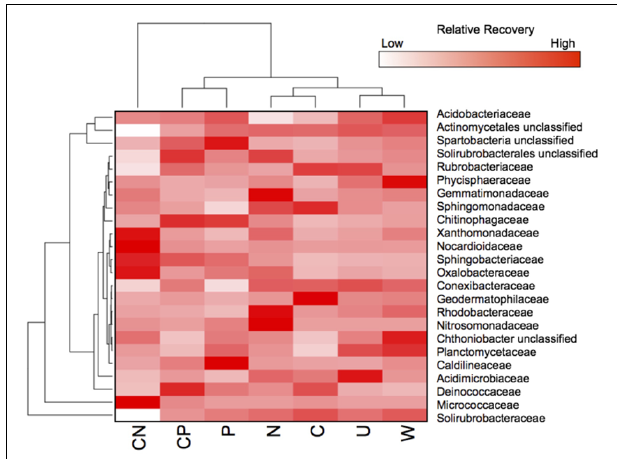
FIGURE 3 | All resources, except water, promoted different taxonomical shifts. Heat map showing the distribution of OTUs for fourteen families that contributed ≥ 0.5% to the total recovery of communities. Treatment abbreviations are described in Figure 1 . Values are based on means with hierarchal clustering of resource treatments (bottom) and family (left).